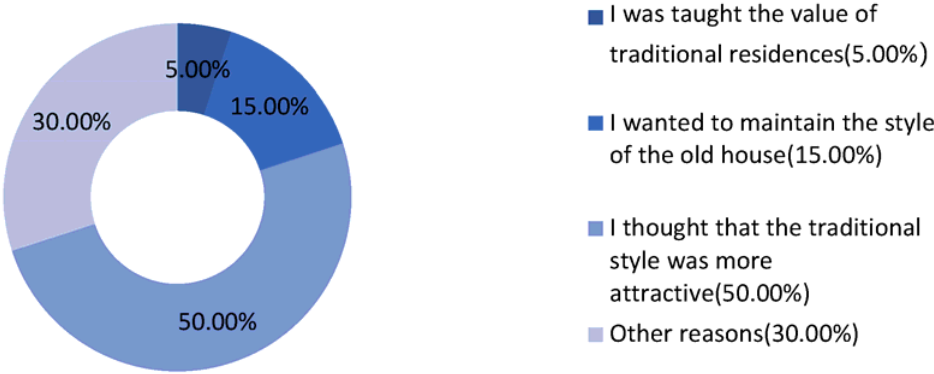
Figure 6. The reasons for choosing the traditional roof. The original question was “Why did you choose the traditional roof?”.